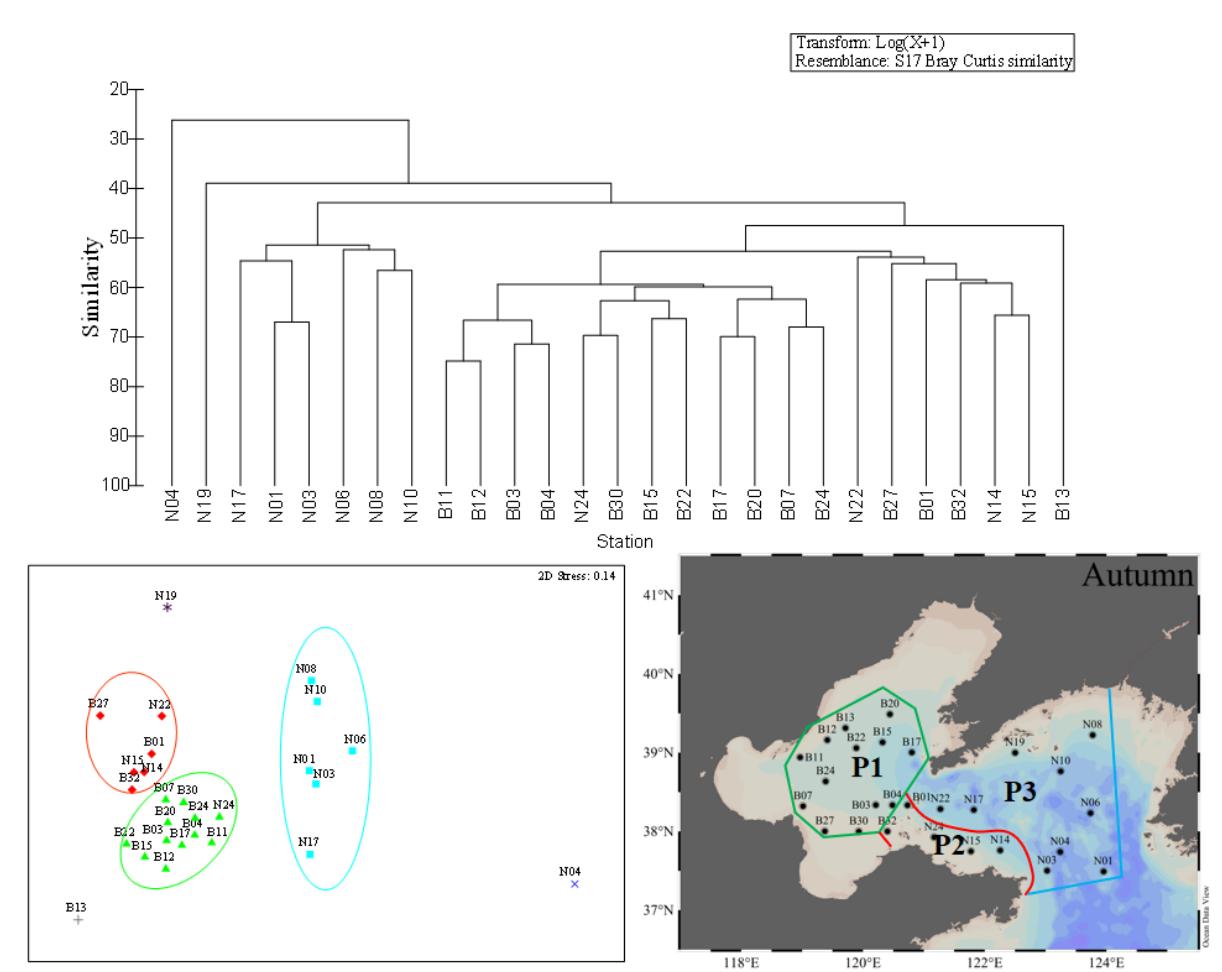
Figure 7. Cluster analysis (left) and MDS (right) of the top 15 dominant species with station in autumn. Each symbol represents a sampling station: green triangles = fourth assemblage; blue squares = fifth assemblage; red diamonds = sixth assemblage.